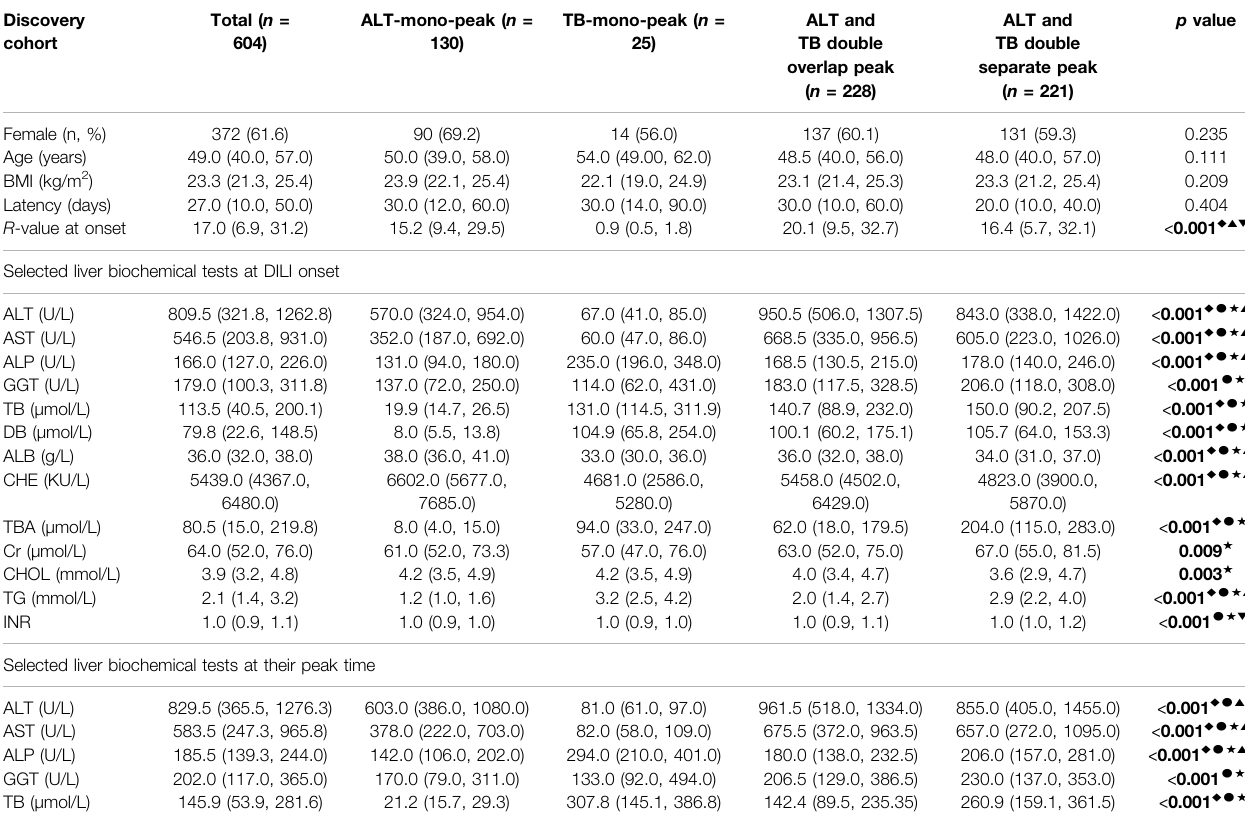
TABLE 1 | Comparison of the demographic data and liver biochemical parameters among the four ALT-TB dynamic evolution patterns in DILI. Discovery